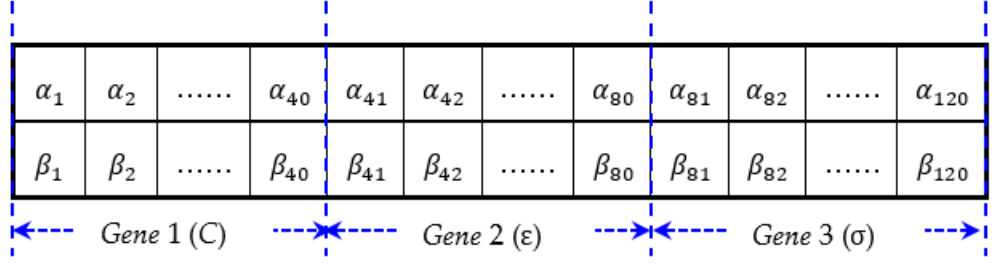
Figure 2. Quantum chromosome structure for three parameters.